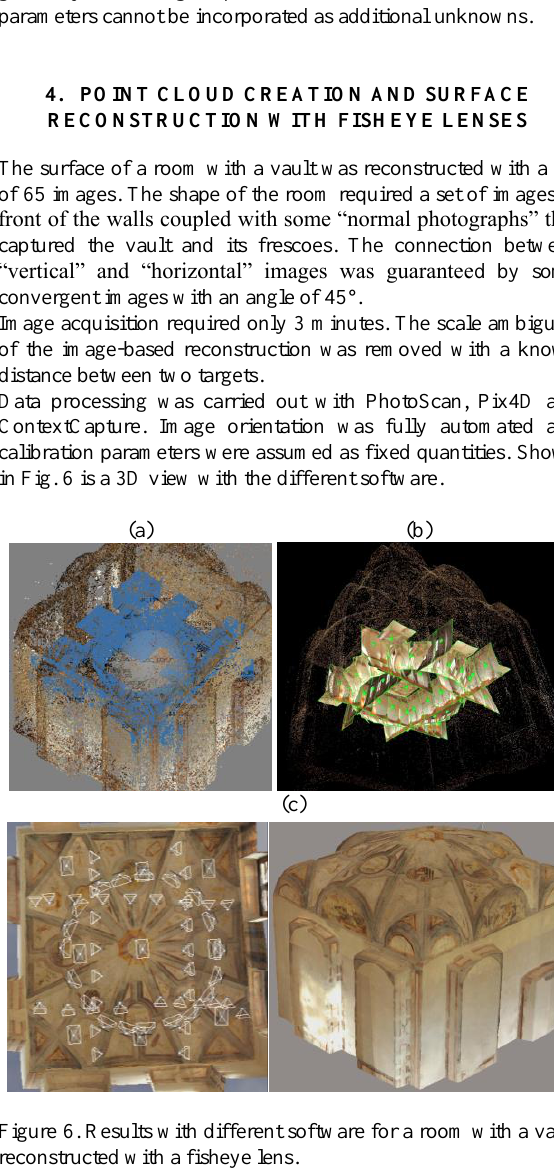
Figure 5. Results with calibration parameters estimated in the orientation step (a straight wall becomes a circular sector). The geometry of a long sequence is not reliable and calibration parameters cannot be incorporated as additional unknowns.